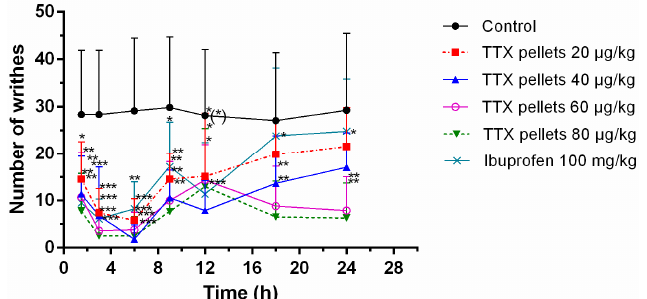
Figure 5. Number of the writhes of acetic acid treated rats after sustained-release TTX pellets treatment. Saline, TTX formulation or ibuprofen was intragastrically (i.g.) administrated at 0 h.